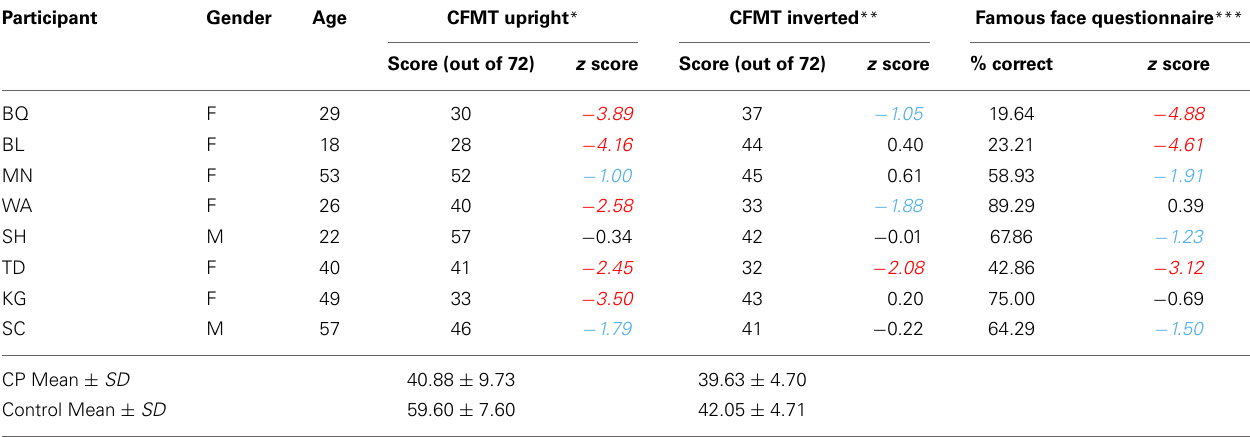
Table 1 | Biographic details and results (raw values and z scores) of face perception measures for 8 CP individuals.